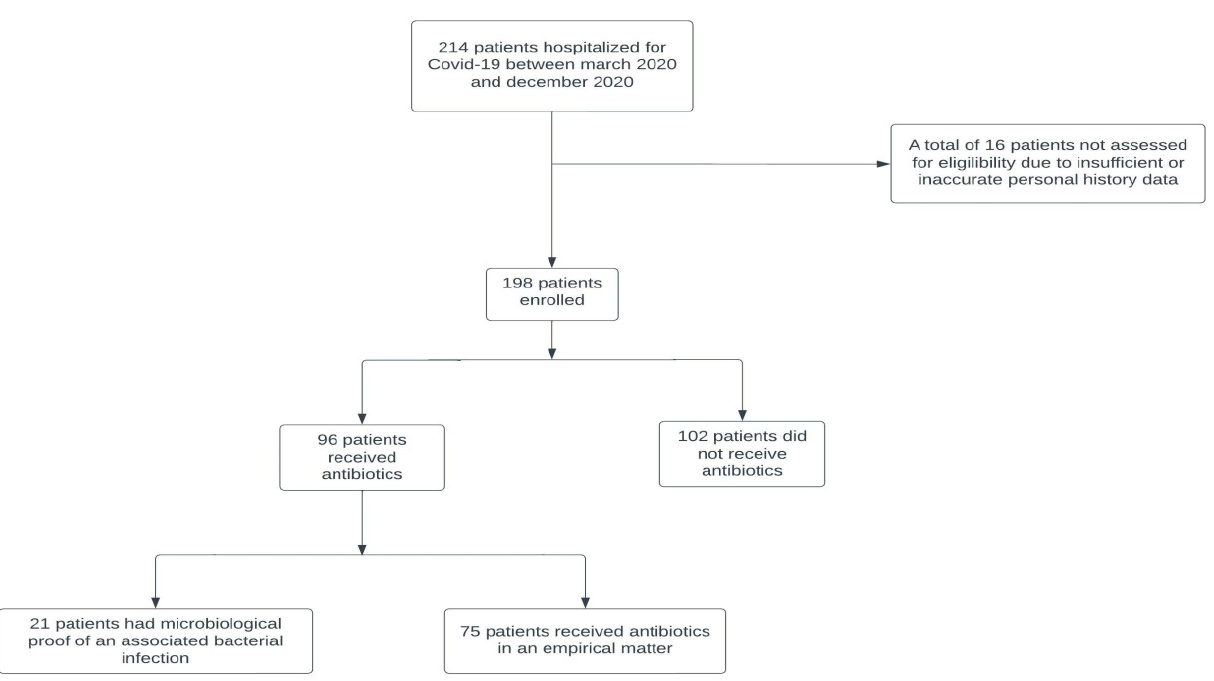
Figure 1. Study Figure 1. Study design.